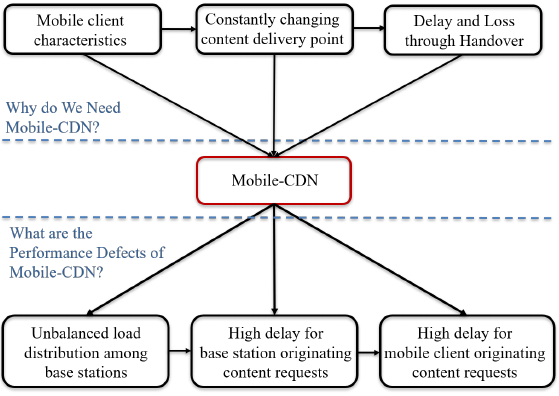
Figure 2. Mobile-CDN Summary.